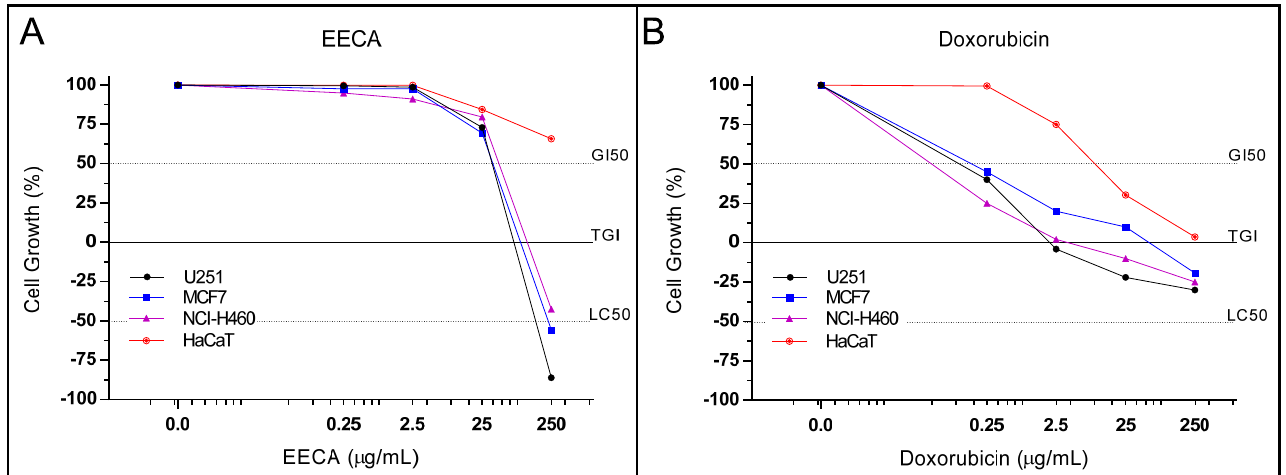
Figure 3. ( A ) Cell proliferation curve as a function of the EECA concentration dissolved in a DMSO/RPMI/5% FCS medium. Figure 3. ( B ) Cell proliferation curve as a function of Doxorubicin concentration. The effective concentration resulting in TGI (total growth inhibition, concentration required for a total inhibition of cell proliferation) was calculated by sigmoidal, nonlinear regression. GI50: concentration that produces 50% cell growth inhibition or cytostatic effect; TGI: concentration that resulted in total cellular growth inhibition; LC50: concentration that produces 50% cell death or cytotoxic effect. EECA: ethanolic extract of the rhizome of C. articulatus